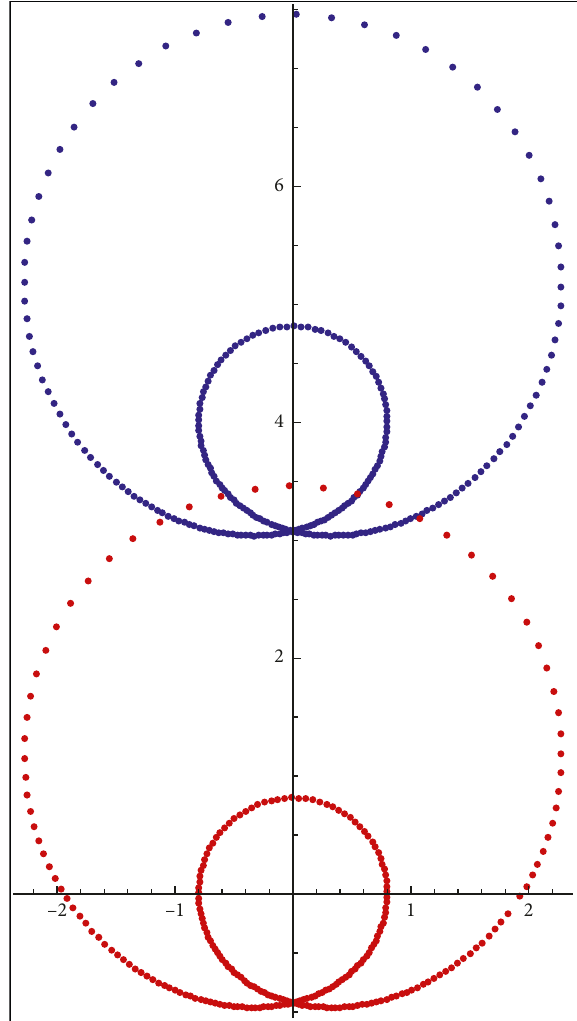
( t ) (top curve) and h 0